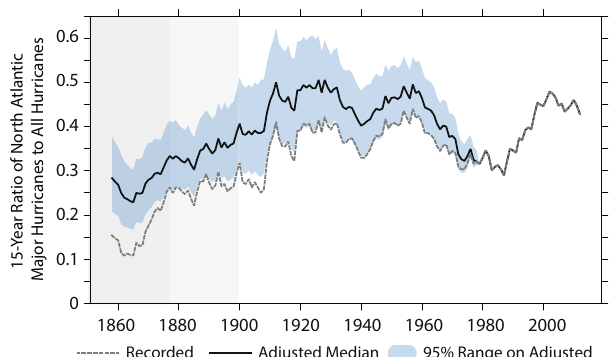
95% Range on AdjustedRecorded Adjusted Median Fig. 4 Ratio of North Atlantic major hurricanes to overall hurricanes. Ratio of the 15-year running count in North Atlantic basin-wide major hurricane to hurricane frequency. Gray line shows data based on version 2 of the North Atlantic Hurricane Database (HURDAT2, ref. 33 ) recorded frequencies, while the blue line shows the ratio based on the mean adjusted frequencies (light blue shading shows the 95% range based on a Bootstrap resampling of the adjustment). Gray background shading is as in Fig. 1, and highlights times where we have reduced con fi dence in the frequency estimates even after adjusting for likely missing